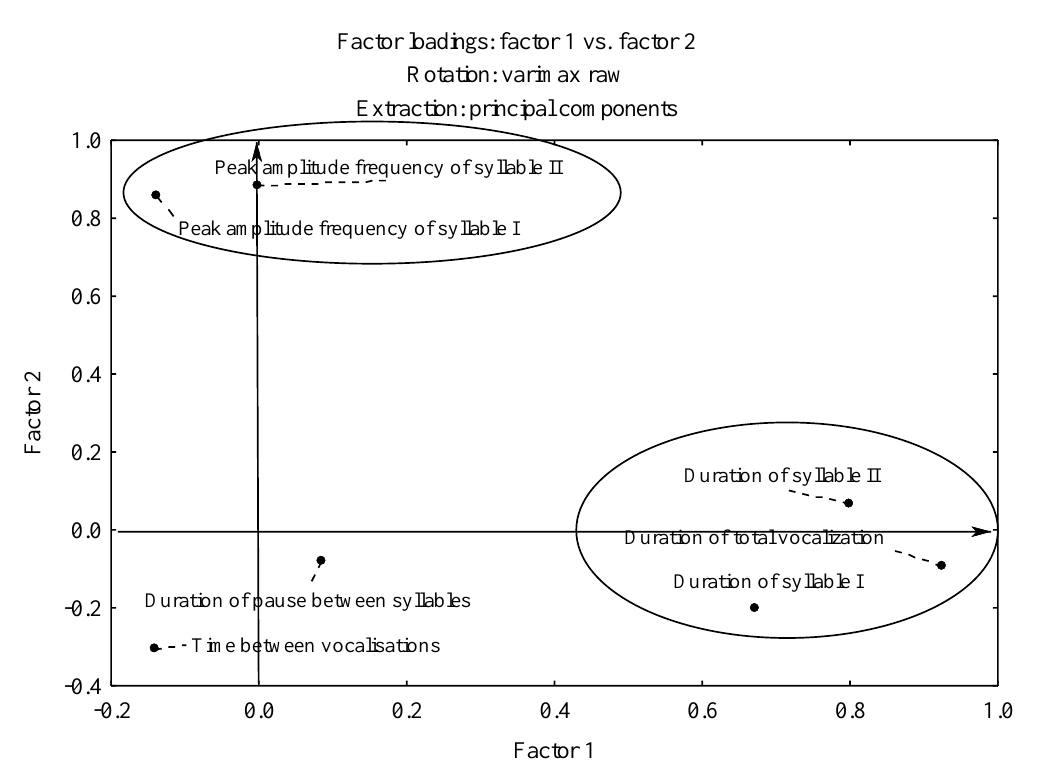
Figure 4. The plot of the projection of variables onto the plane of the first two factors after Varimax rotation.